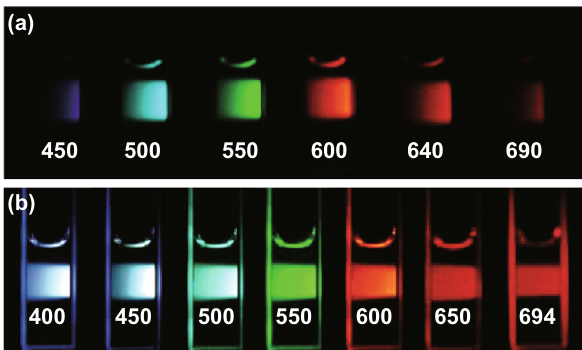
Fig. 1 Aqueous solution of passivated CDs. a Excited at 400 nm and imaged through bandpass filters as indicated, and b excited at the indicated wavelength [15]. Copyright (cid:2) 2006 American Chemical